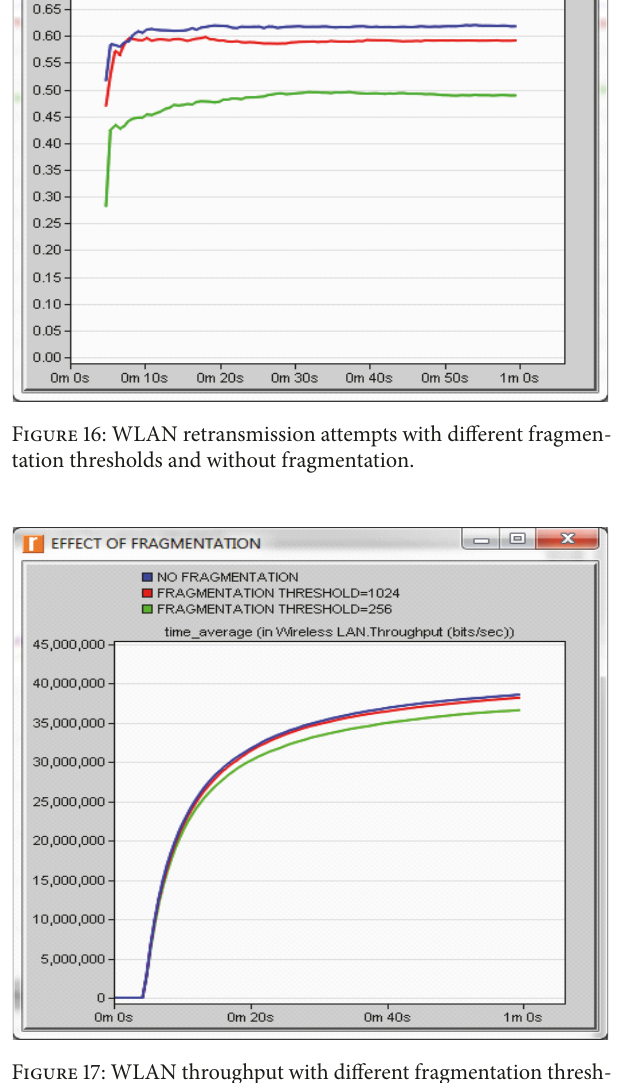
Figure 17: WLAN throughput with different fragmentation thresh- olds and without